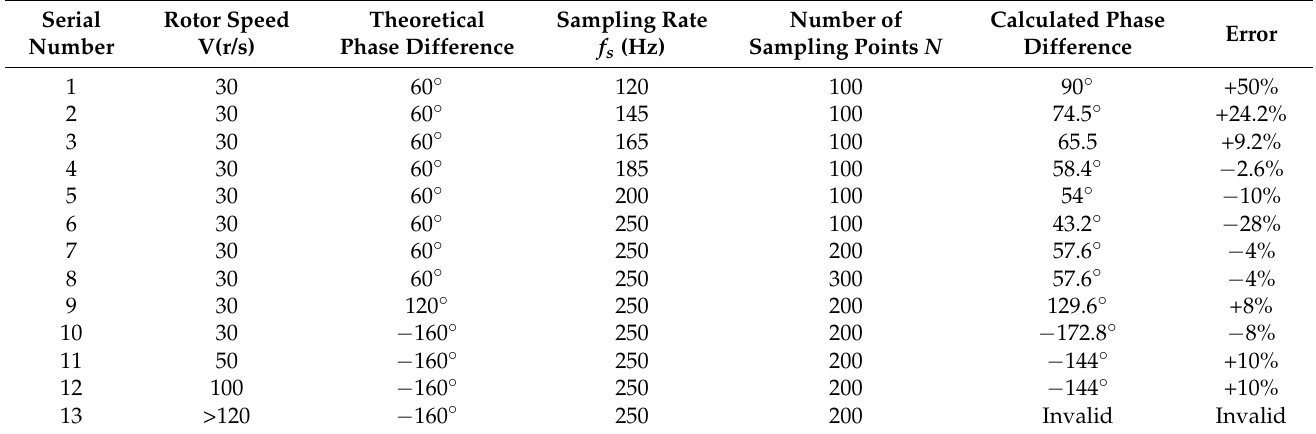
Table 1. The relationship between error and sampling rate and sampling